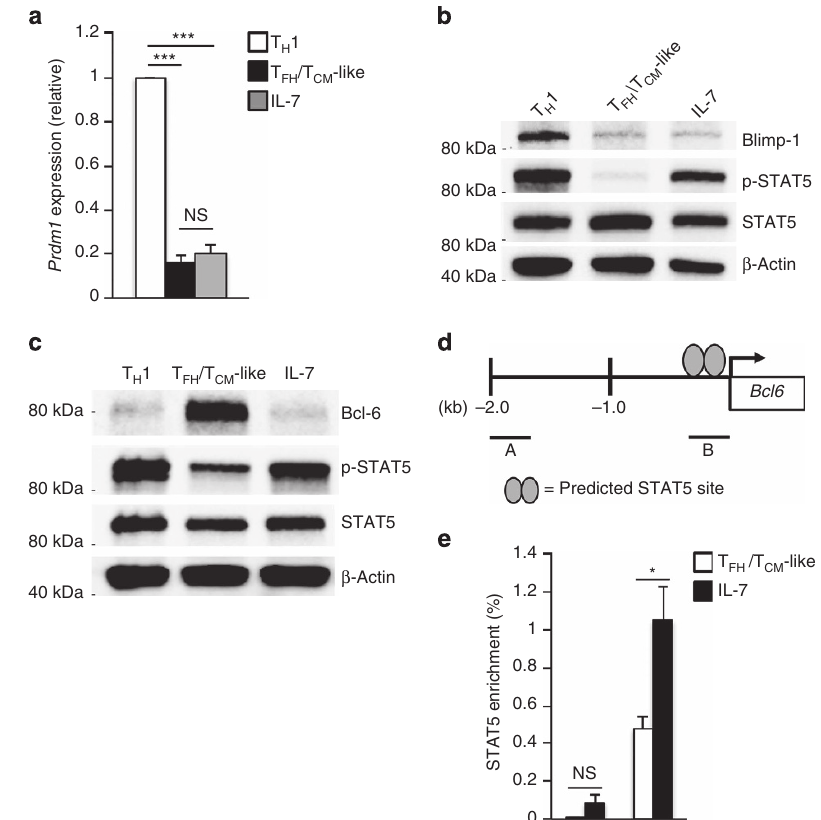
Figure 6 | IL-7-induced repression of Bcl-6 is mediated via STAT5 and independent of Blimp-1. ( a ) qRT–PCR or ( b ) immunoblot analysis of Blimp-1 expression in T H 1, T FH /T CM -like cells, and T FH /T CM -like cells exposed to IL-7. In a , data were normalized to Rps18 as a control and the results are presented relative to the T H 1 sample (mean of n ¼ 4 ± s.e.m.). In b , protein expression was assessed using the indicated antibody. b -Actin was monitored as a control for equal protein loading. Shown is a representative blot of three independent experiments. ( c ) Immunoblot analysis of Bcl-6, phospho-STAT5 (p-STAT5) and STAT5 expression in primary T H 1 cells, T FH /T CM -like cells and T FH /T CM -like cells exposed to IL-7. b -Actin was monitored to ensure equal protein loading. Shown is a representative blot of three independent experiments. ( d ) A schematic indicating the location of a predicted tetrameric STAT5 binding site in the promoter of the Bcl6 locus. PCR amplicons used in the chromatin immunoprecipitation (ChIP) analysis are indicated as ‘A’ and ‘B’. ( e ) ChIP assay to assess STAT5 association with the Bcl6 locus in response to IL-7-signalling. Data are represented as percent enrichment relative to a ‘total’ input sample (mean of n ¼ 3 ± s.e.m.). * P o 0.05, *** P o 0.001 (unpaired Student’s t -test). NS, not